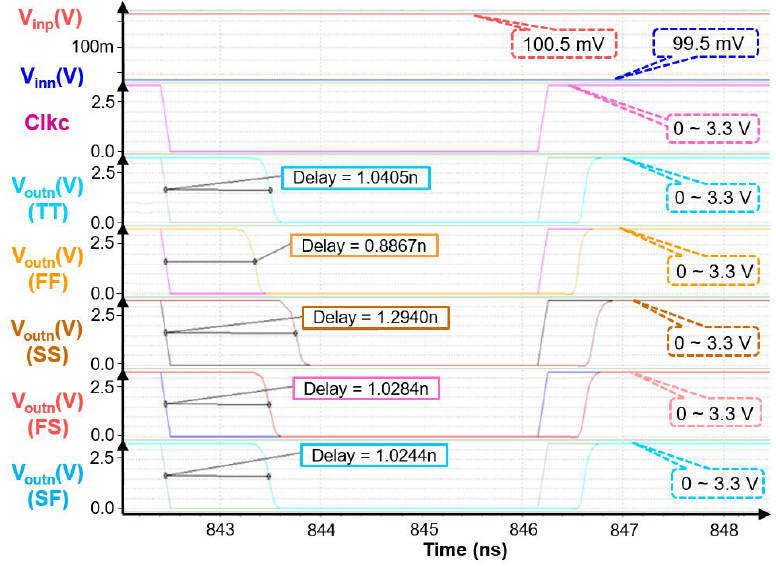
Figure 18. Simulated propagation delays at five process corners with common-mode voltage of 100 mV.